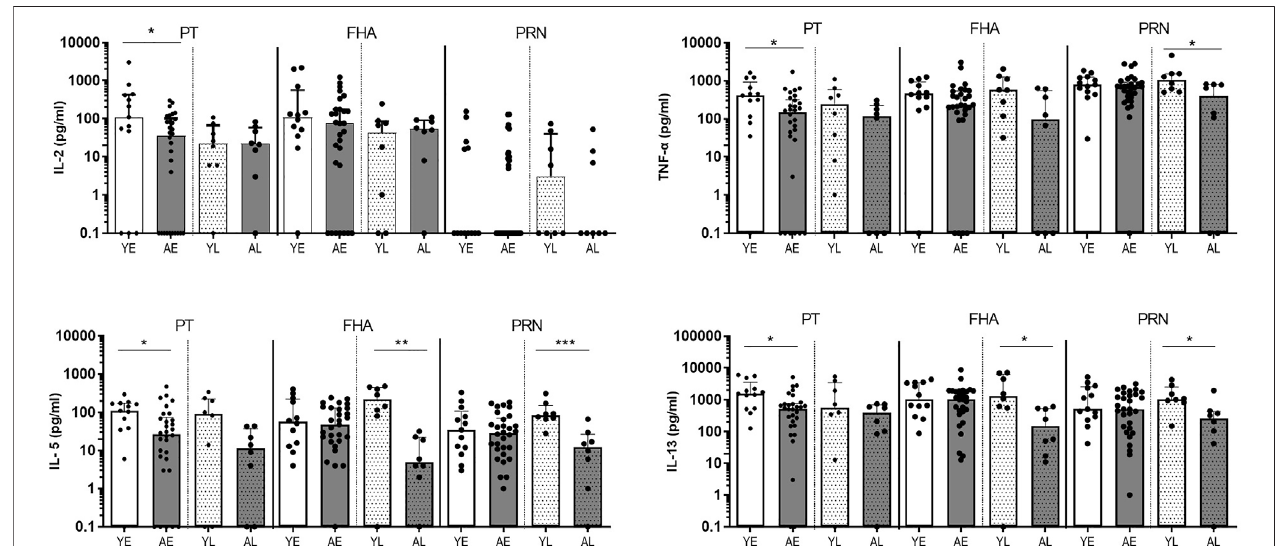
FIGURE2| AdultsshowlowerlevelsofsecretedTh-typecytokinesafterpertussisinfection(SKI).BargraphsshowtheconcentrationofIL-2,TNF- α ,IL-5,andIL-13 insupernatantsofPBMCs invitro stimulatedwithBpproteins PT (leftpanels) ,FHA (middle panels) and PRN (rightpanels) inyoungsters( “ Y ” ,whitebars)andadults ( “ A ” , dark bars) inearly( “ E ” , open bars) and late ( “ L ” , dotted bars) phase after clinical diagnosis. Dots show individual cases while bars indicate medians and interquartile range. Statistical signi fi cance was calculated with Mann Whitney U -test. * p < 0.05, ** p < 0.01, *** p < 0.001.